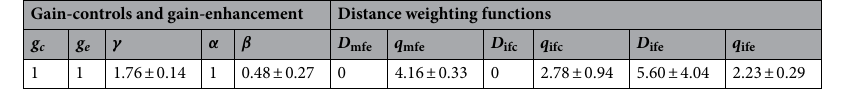
Table 3. Model 1